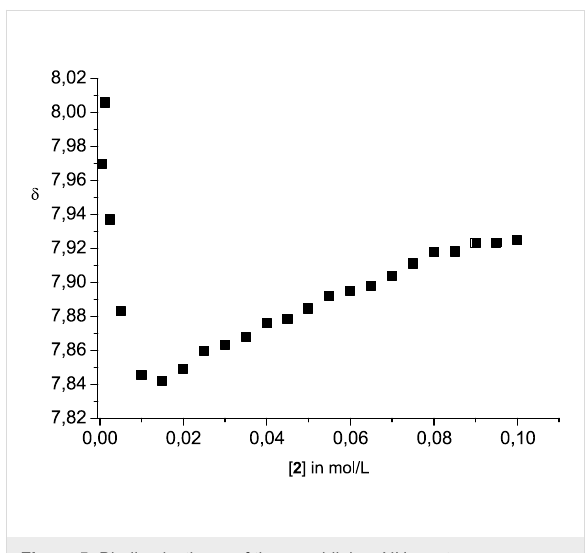
Figure 5: Binding isotherm of the guanidinium NH 2